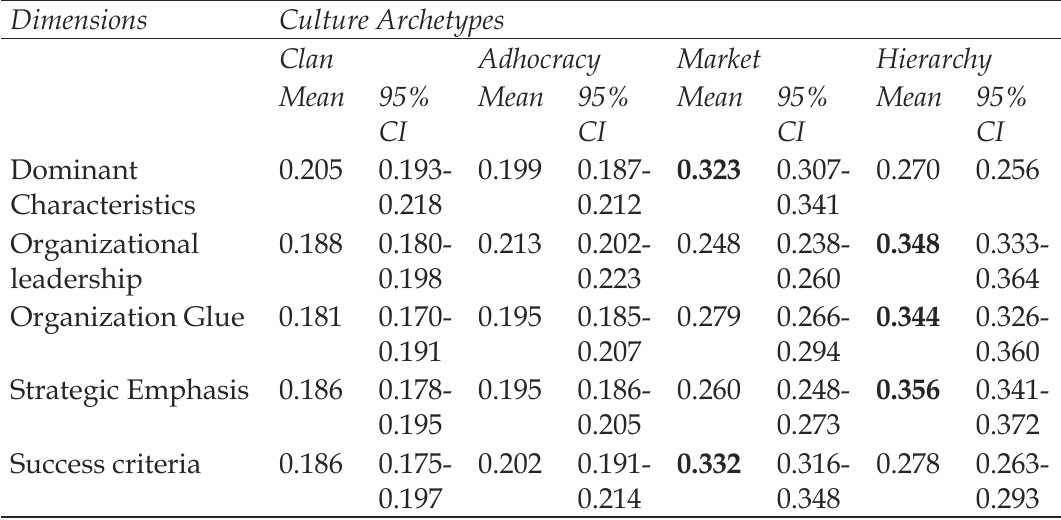
Culture archetypes of Turkish Universities per dimension Dimensions